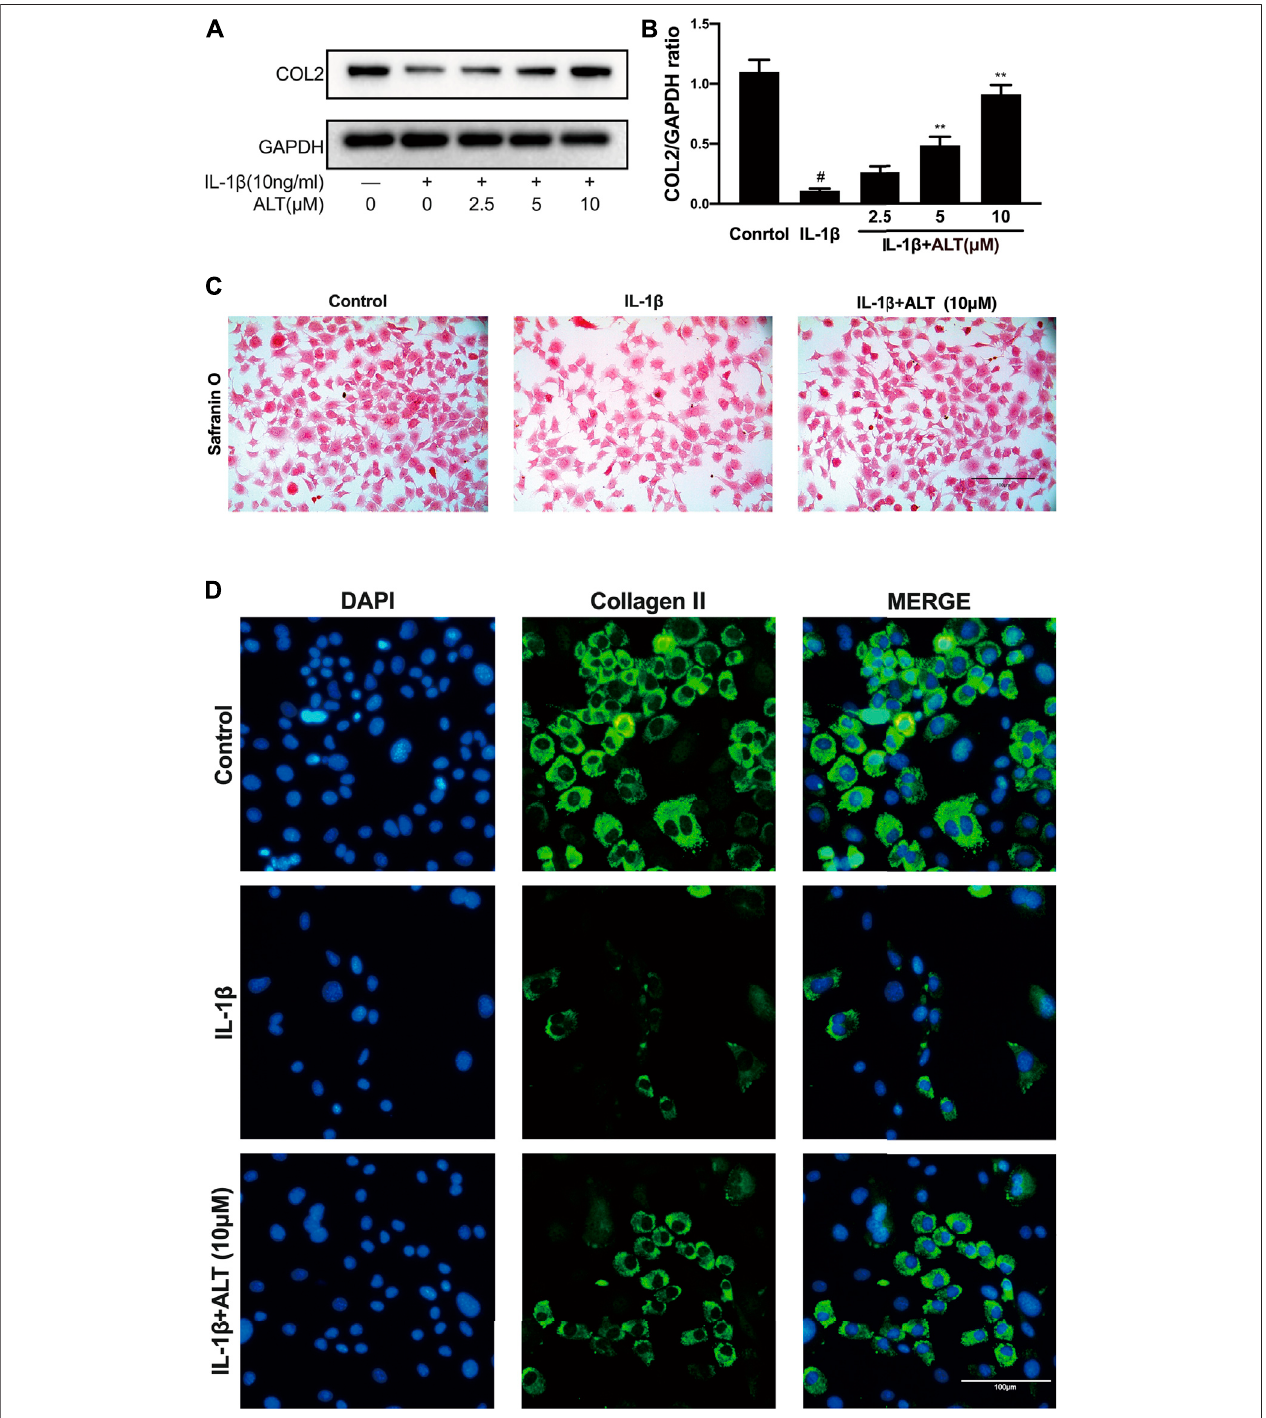
FIGURE 4 | ALT attenuated the degeneration of Collagen II induced by IL-1 β in mouse chondrocytes. (A) Western blotting result of Collagen II. (B) Quanti fi cation analysisofwesternblottingresults, GAPDHwasregardedasaninternalcontrol ( n (cid:2) 3). (C) SafraninOstainingforproteoglycans depositionineach groupafter a7-days incubation(scalebar100 μ m). (D) CollagenIIexpression wasdetermined byimmuno fl uorescencestaining(scalebar100 μ m).# p < 0.05vs.controlgroup;* p < 0.05vs. IL-1 β group; ** p < 0.01 vs. IL-1 β group.